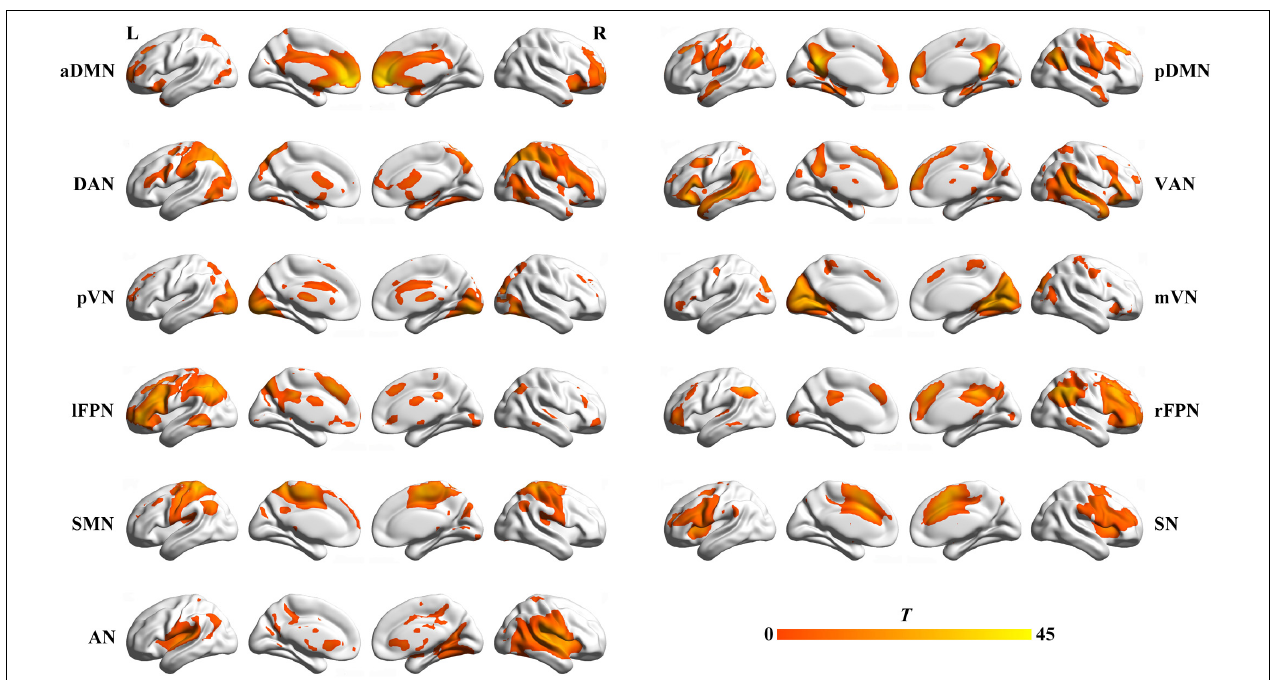
FIGURE 1 | Spatial maps of 11 selected functional networks. aDMN, anterior default mode network; pDMN, posterior default mode network; DAN, dorsal attention network; VAN, ventral attention network; pVN, posterior visual network; mVN, medial visual network; lFPN, left frontoparietal network; rFPN, right frontoparietal network; SMN, sensorimotor network; SN, salience network; AN, auditory network; L, left; R,